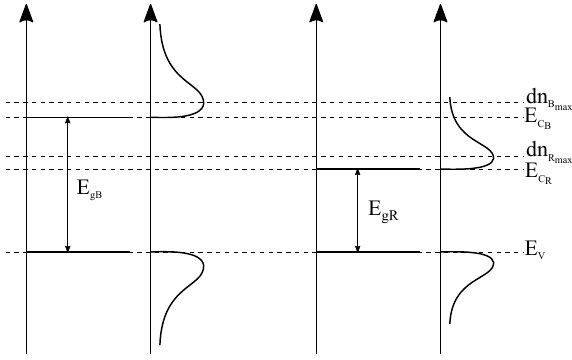
Figure 6. Example of energy levels and carriers for a Blue (B) LED on the left and for a Red (R) LED on the right.